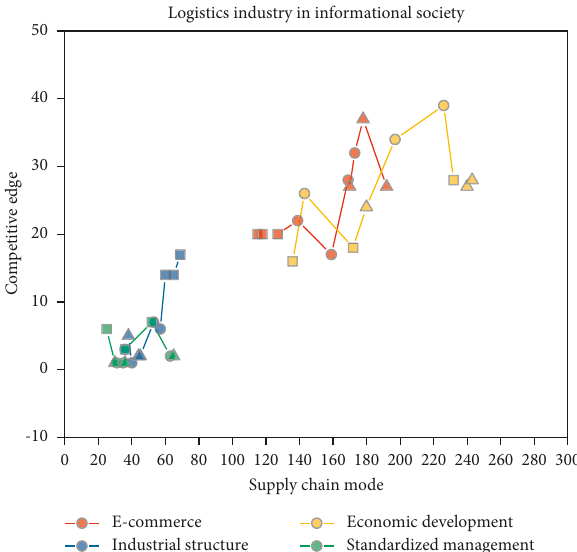
Figure 6: Relationship curves among the competitive edge virus the e-commerce, industrial structure, economic development, and standardized management in logistics